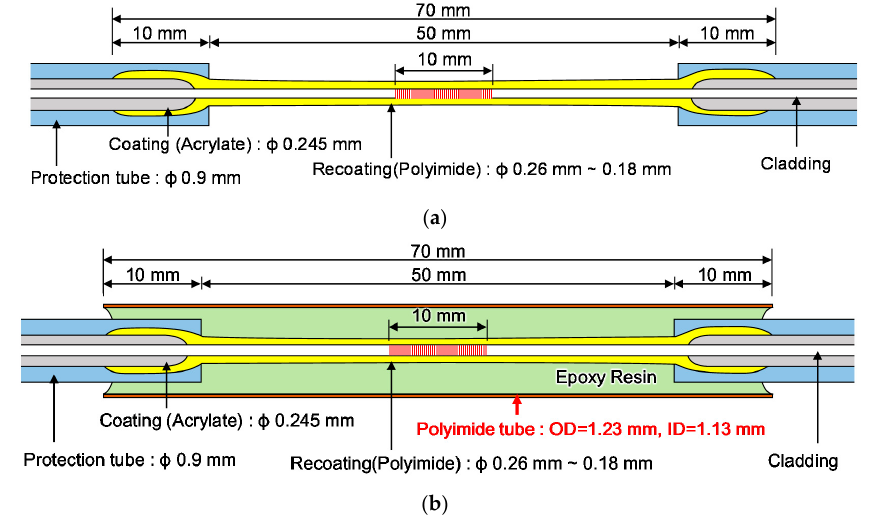
Figure 11. Schematic diagram of FBG sensors: ( a ) FBG-P-NP (without a polyimide tube); ( b ) FBG-P- PP (with a polyimide tube).